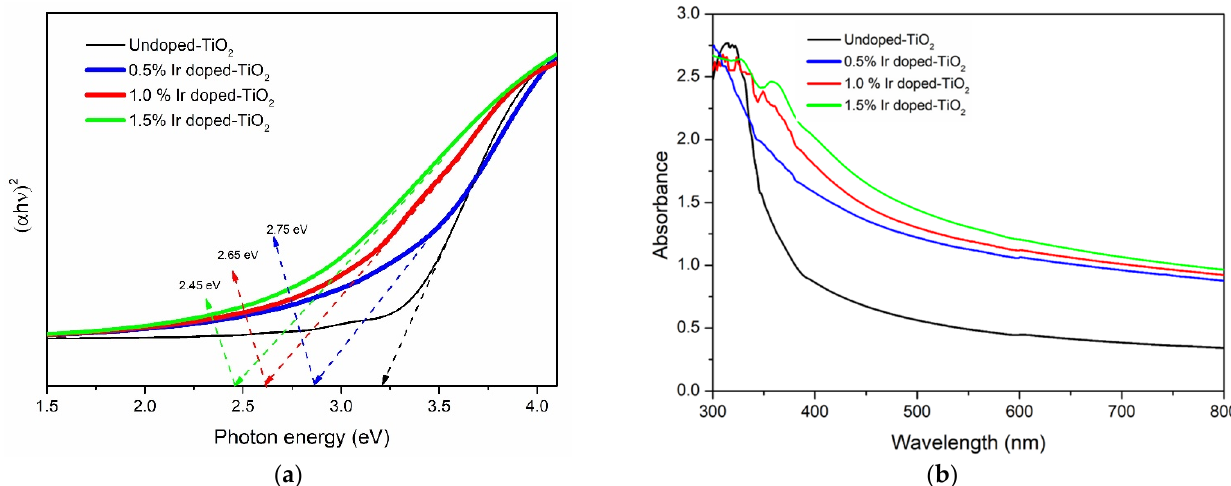
Figure 7. ( a ) UV–Vis absorbance spectrum and ( b ) Tauc plot of Ir-doped TiO 2 and pristine TiO 2 . The air containing 1901 mg/m 3 toluene was pumped through the system to determine the photocatalytic activity of the photocatalysts having different iridium concentrations (0.5, 1.0 and 1.5 mol%) and the concentrations of residual toluene were 1361, 887 and 47.5 mg/m 3 respectively. As shown in Figure 8, between the three photocatalysts, the 1.5 mol% Ir-doped photocatalyst had the highest degrading efficiency while 0.5 mol% Ir-doped sample had the lowest one. We found that the efficiency in toluene degradation without illumination was 3.45%; this could be explained by the adsorption of toluene on the catalyst surface. Importantly, the degradation efficiency of 1.5 mol% Ir-doped material was more than 97%, while the TiO 2 /ACFs photocatalyst only had a conversion rate of 14.2% at 25 ◦ C and relative humidity of 60% [41]. This could be explained by the impact of the iridium doping process on TiO 2 material which helps to reduce the electron-hole recombination rate by trapping charge carriers. A mechanism of dopant trapping, and mediating charges was proposed by Choi et al. [42], indicating that each photocatalyst should have an optimum metal doped concentration. Our finding is consistent with that of Choi et al. whereas the efficiency would rise to a certain value with the increase of doped iridium concentration. In the present study, 1.5 mol% iridium-doped material showed the higher decomposing efficiency compared to two other doped TiO 2 . Therefore, in the following experiments, we used 1.5 mol% Ir-doped TiO 2 to make further investigations. In this work, the 1.5% ratio of iridium was chosen to dope into TiO 2 because only a small amount of iridium can reduce the absorbed photon energy of TiO 2 , therefore we could apply this material in air treatment. However, reducing the bandgap may be not good due to the recombination of hole and electron so that it would decrease the efficiency of catalyst performance. In addition, iridium is quite expensive, so a larger ratio of iridium would not be so economically